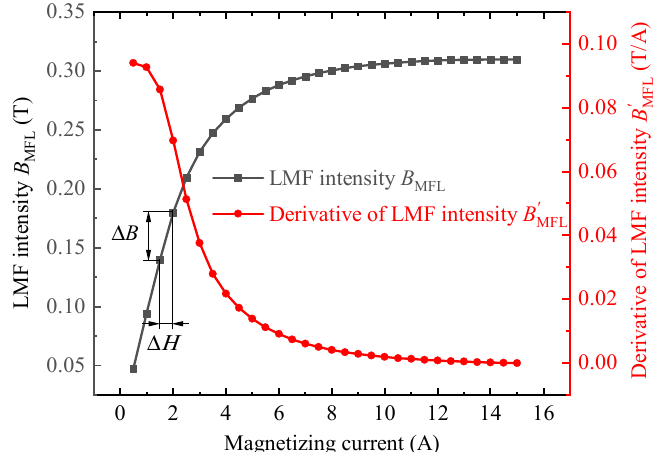
Figure 5. The change of the slot LMF intensity B MFL and its derivative B (cid:48) with different mag- netizing currents.